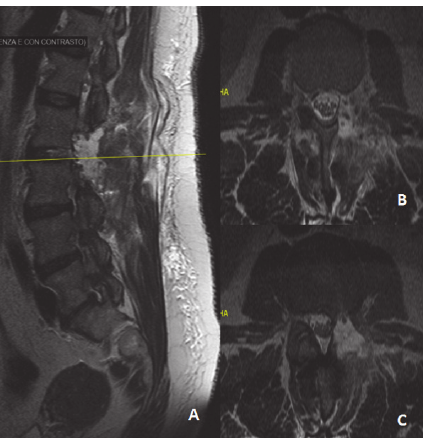
Figure 3: A postoperative MRI scan demonstrating complete resection of the sequestered disc material. Note the decompression of the dural sac and nerve root. L2-L3 arthrectomy and interspinous fixation at the same level were